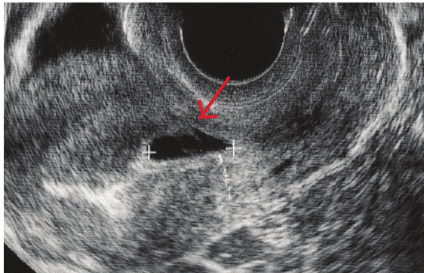
Figure 1: At 6 weeks and 1 day. A wedge-shaped gestational sac (GS) at the site of a previous cesarean scar.